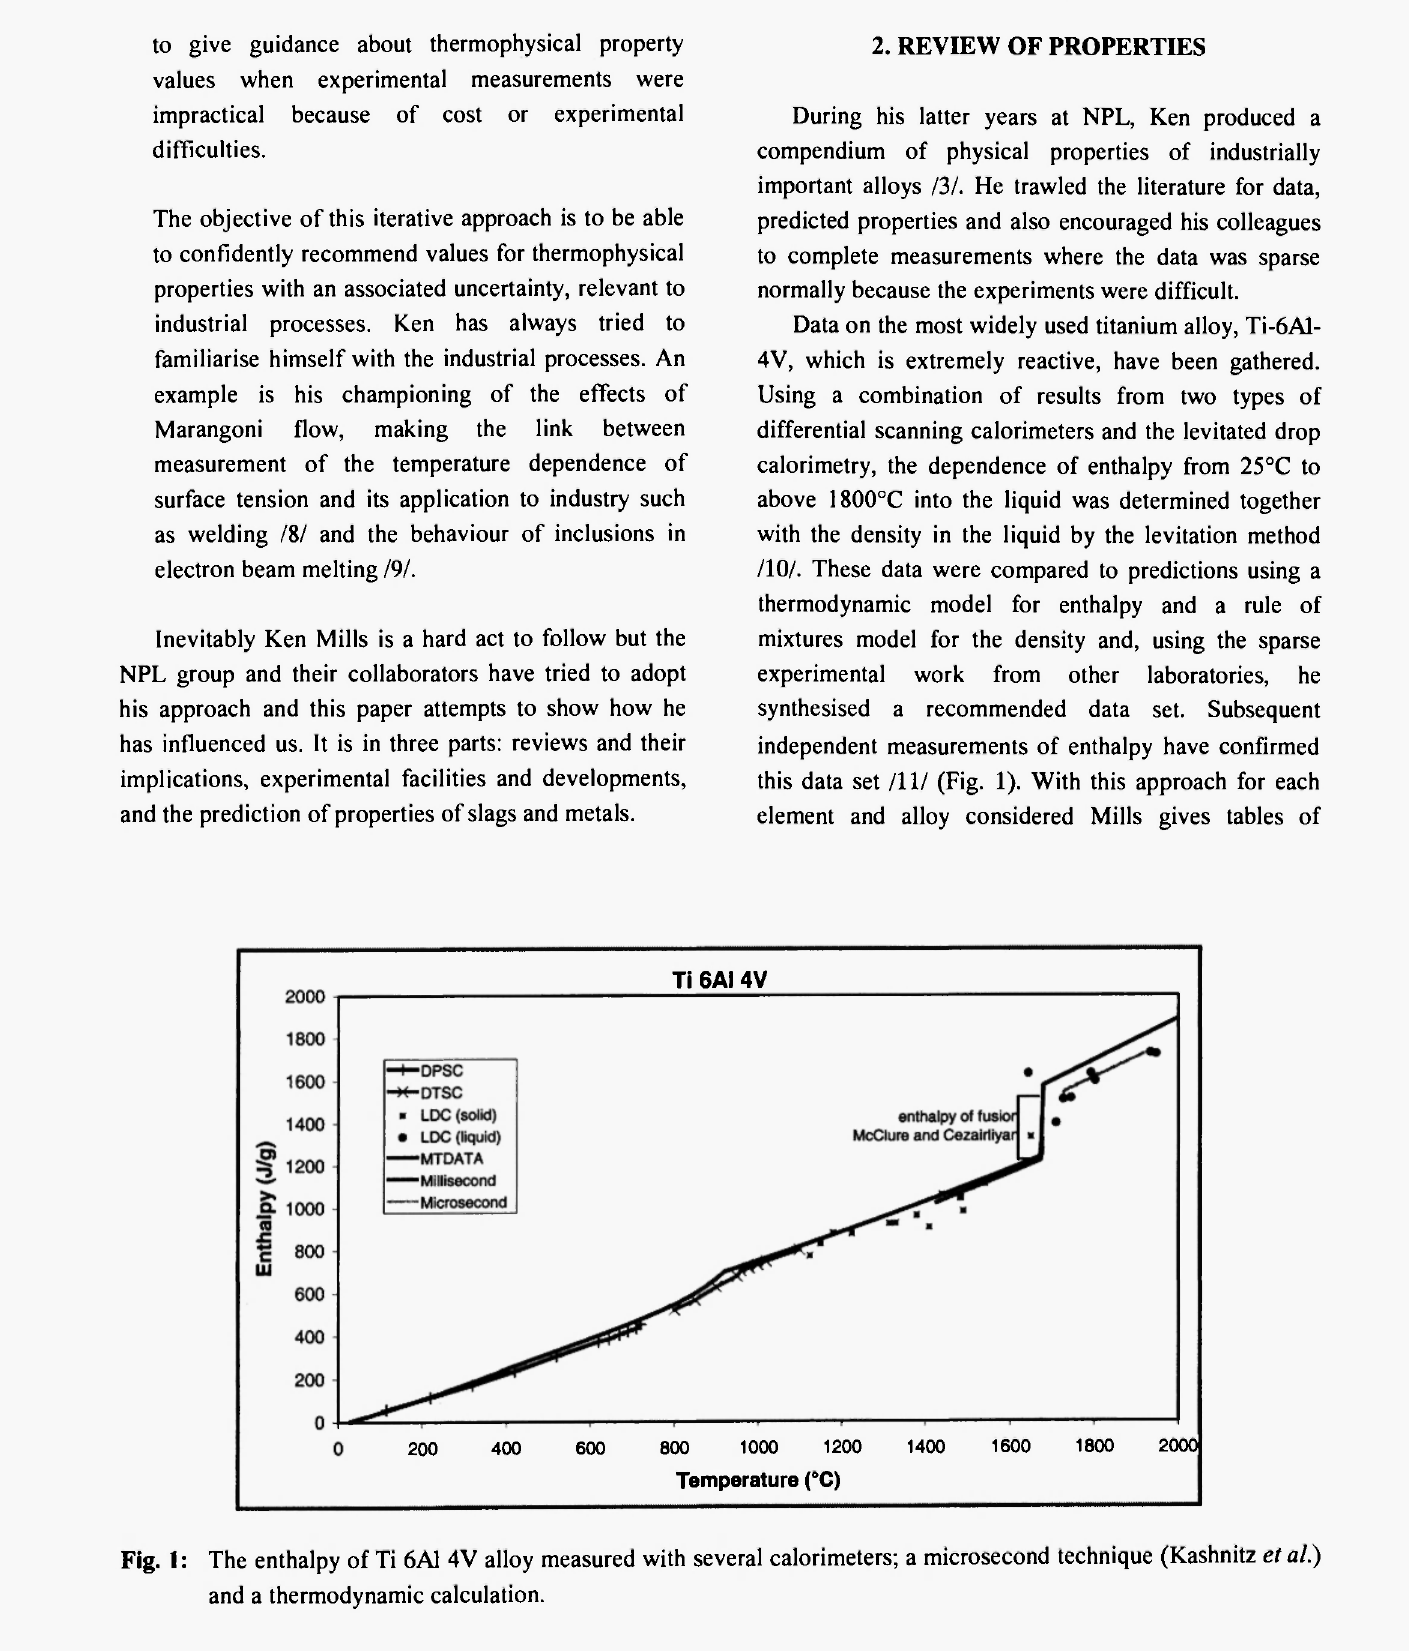
Fig. 1 : The enthalpy of Ti 6A1 4V alloy measured with several calorimeters; a microsecond technique (Kashnitz et al.) and a thermodynamic